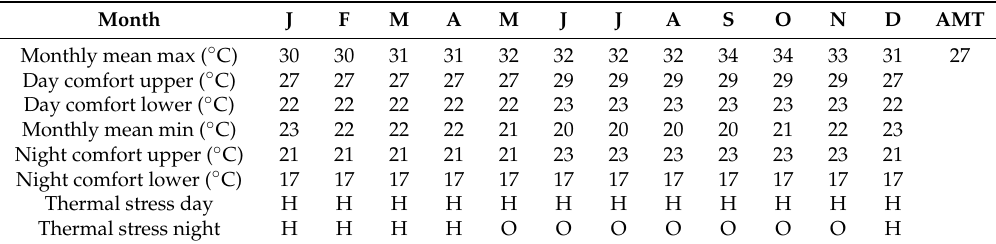
Table 9. Temperature diagnosis.